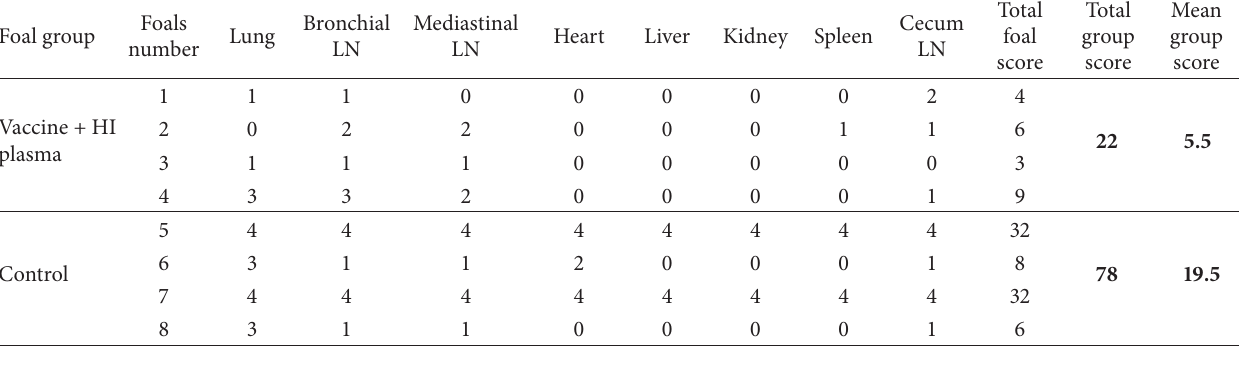
Table 7: Lesion scores of the organs and tissue according to pathological findings.